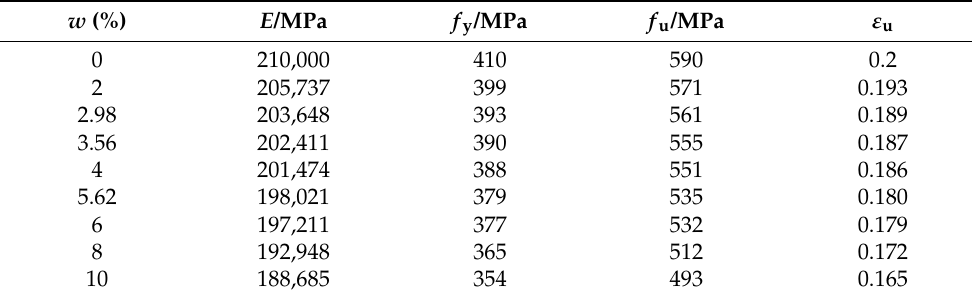
Table 11. Mechanical parameters of the corroded Q355B.